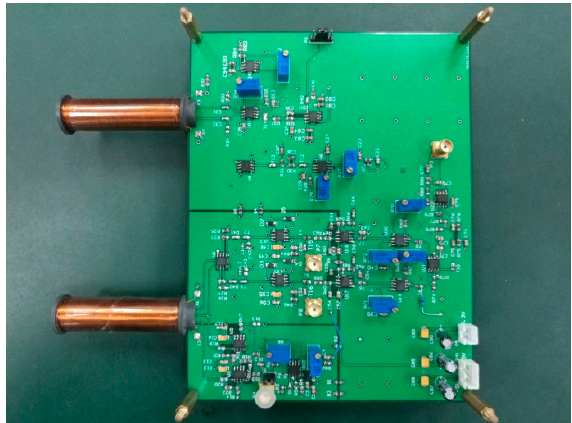
Figure 12. Photograph of the developed GMI sensor.